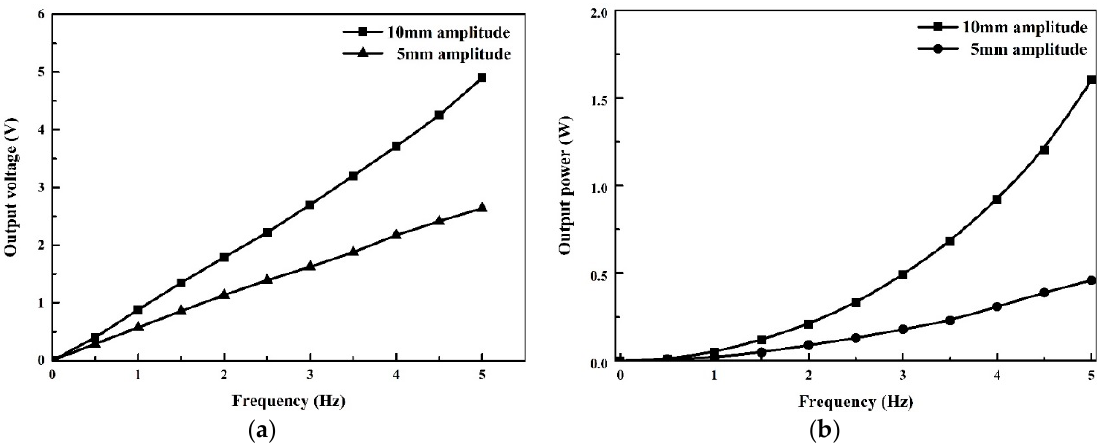
Figure 6. The output voltage and output power of the generator versus the excitation frequency ( R L = 15 Ω ). ( a ) The output voltage versus the excitation frequency; ( b ) The harvested electrical energy versus the excitation frequency.